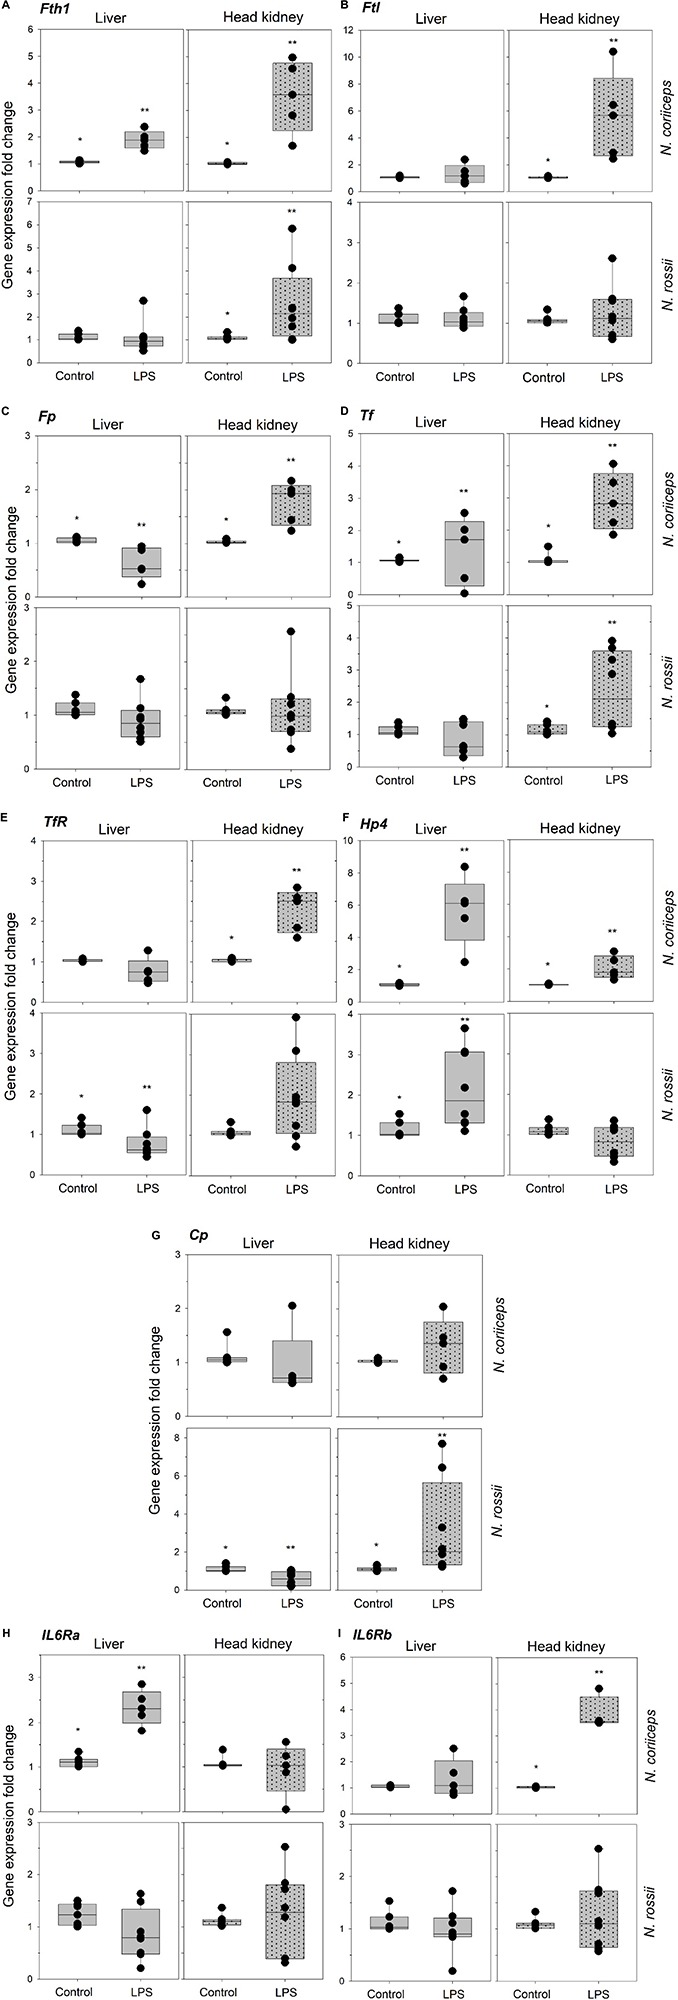
Gene expression of ferritin heavy chain (Fth1) (A), ferritin middle chain (Fm) (B), ferroportin (Fp) (C), transferrin (Tf) (D), transferrin receptor 1(TfRC1) (E), hepcidin 2 (Hamp2) (F), ceruloplasmin (Cp) (G), interleukin 6-receptor alpha chain (IL6Rα) (H), interleukin 6-receptor beta chain (IL6Rβ), (I) in liver and head-kidney of N. coriiceps (NC) and N. rossii (NR) injected with serum saline (Control) or LPS, on day 7 (5 days after last injection). Relative expression was calculated by the 2–ΔΔCT method using the 18s ribosomal protein as the internal reference gene. Each gray bar value is the mean ± SEM and the black dot values correspond to each individual fish (n = 5–7 for N. coriiceps and n = 8 for N. rossii). Asterisks indicate statistical differences between control and LPS treated fish, for each tissue and species (Student’s t-test, P < 0.05).